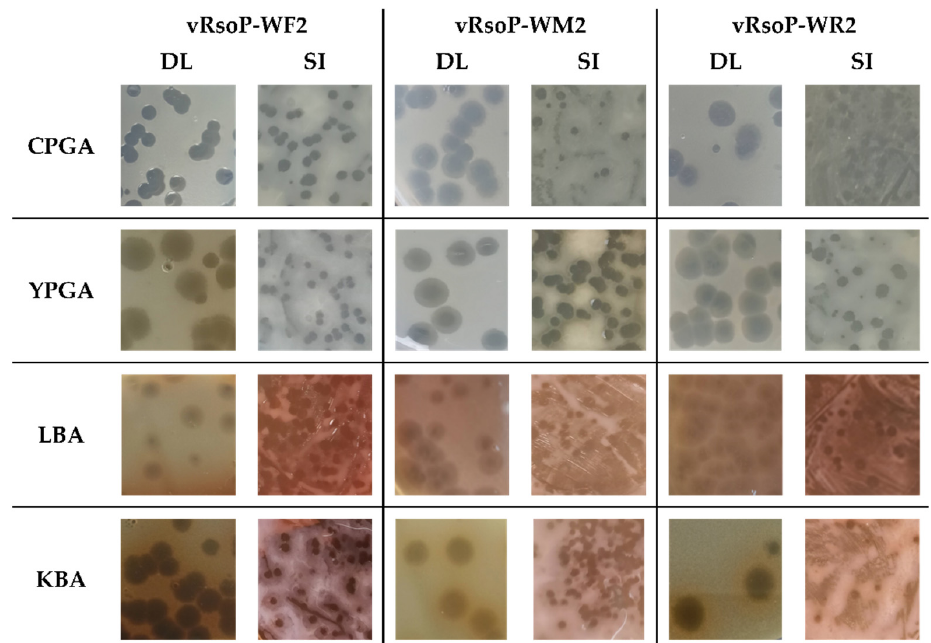
Figure 1. Morphology of vRsoP-WF2, vRsoP-WM2 and vRsoP-WR2 plaques. The phages produced clear plaques surrounded by translucent halos after prolonged incubation with strain CFBP 4944 of R. solanacearum in CPGA, YPGA, LBA and KBA culture media. Clear plaques due to lytic activity were observed after 24 h at 28 °C and the translucent halos around the lytic plaques were increasing in size within time after 2–3 days at 28 °C, and 7 days at 4 °C in double layer (DL) and surface inoculation (SI) methods.